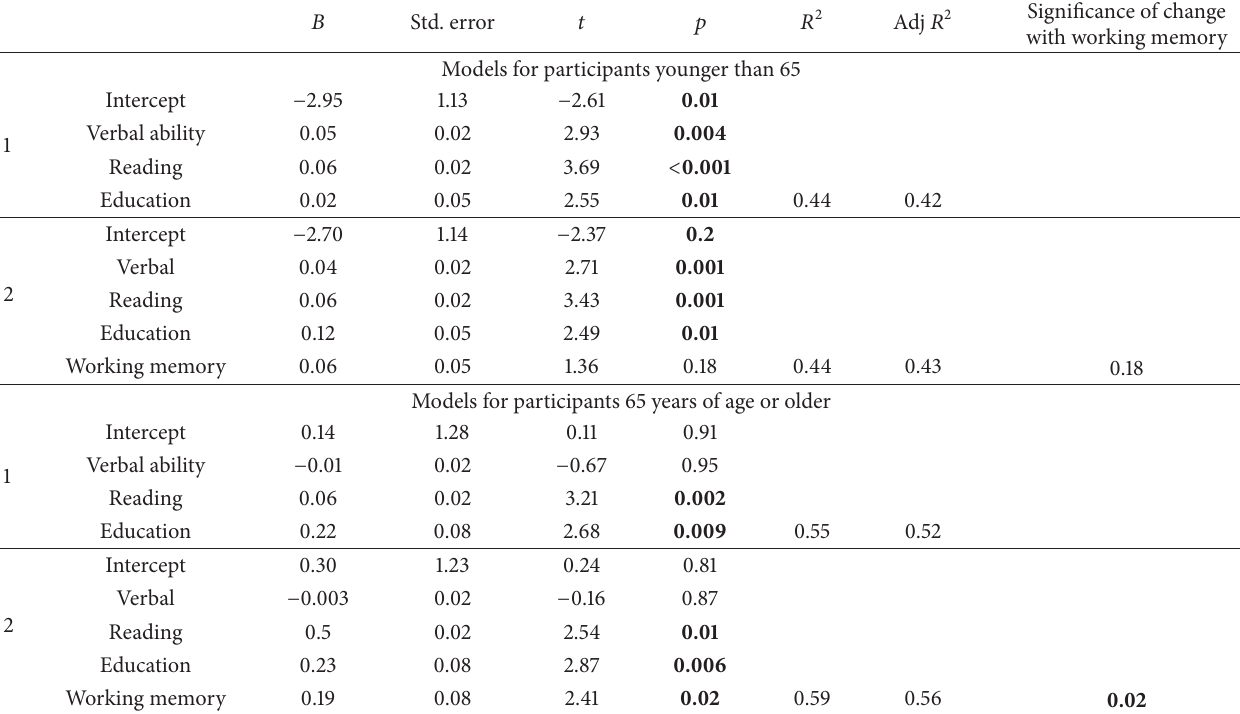
Table 3: Regression models for performance on DIF items for younger and older